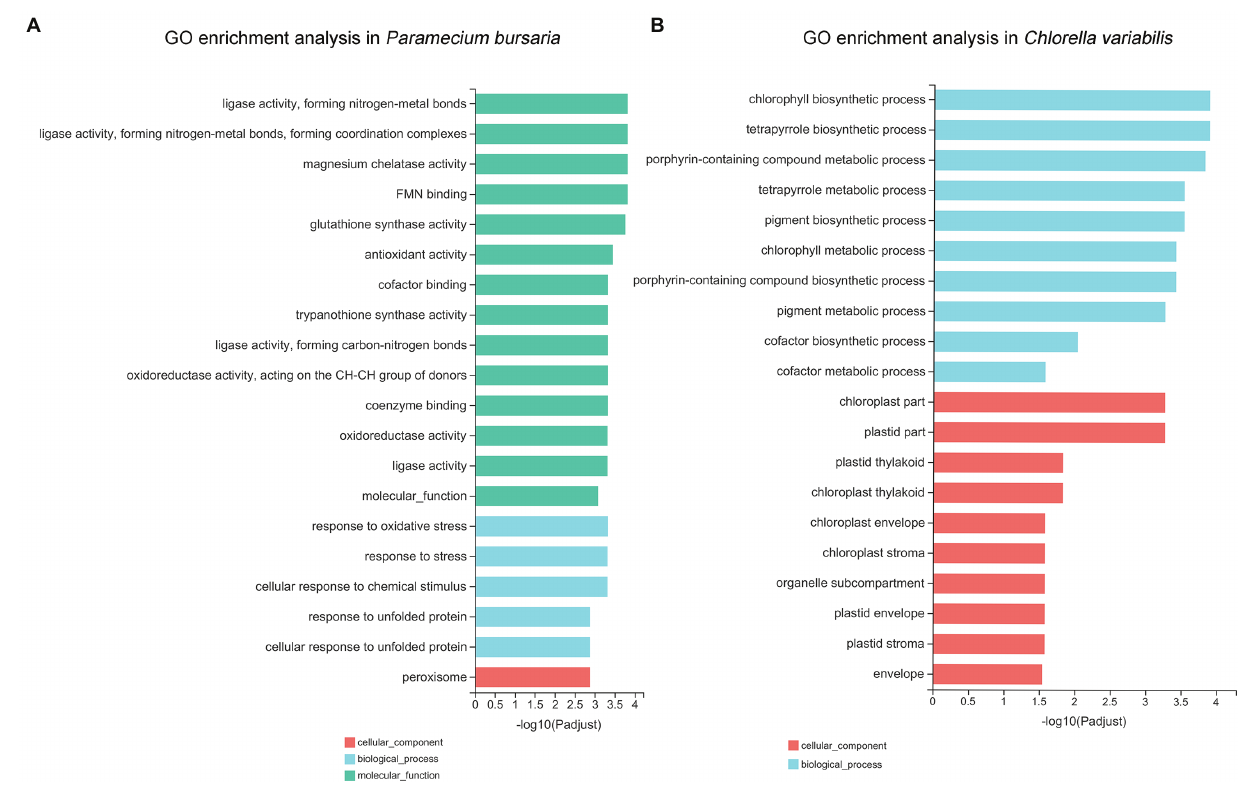
FIGURE 5 | The Gene Ontology (GO) annotations of differentially expressed genes in P. bursaria (A) and C. variabilis (B) . The top 20 GO terms identified for biological process, cellular components, and molecular functions are